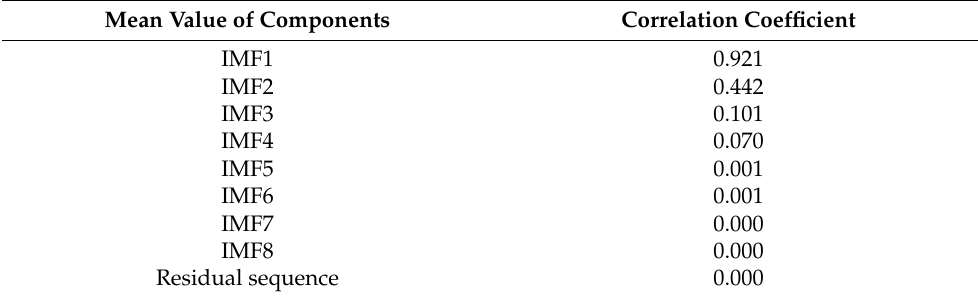
Table 2. Mean correlation coefficient between each component and the original acceleration signal.